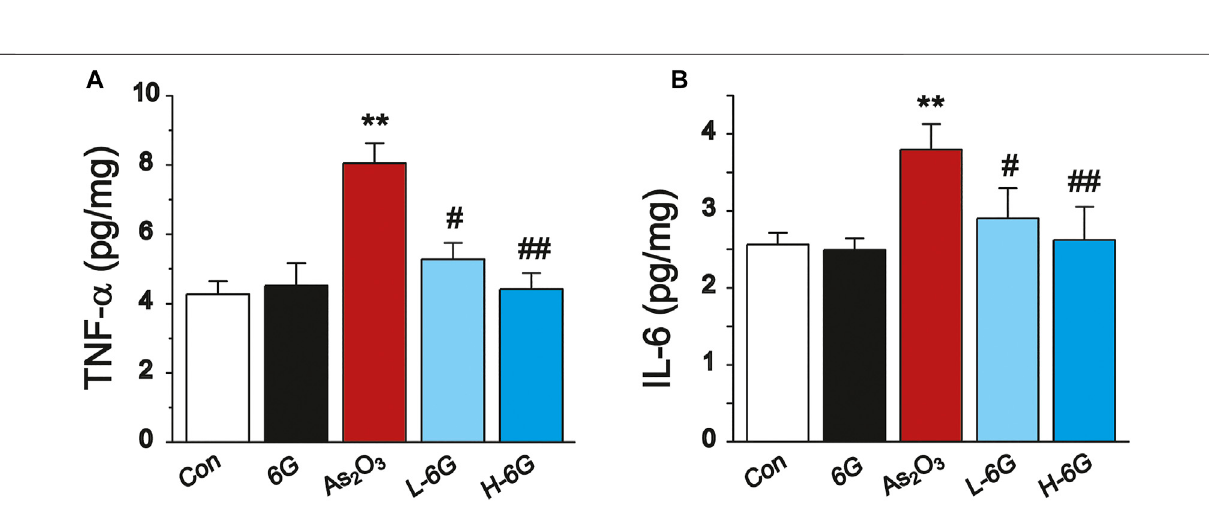
Frontiers in Pharmacology |